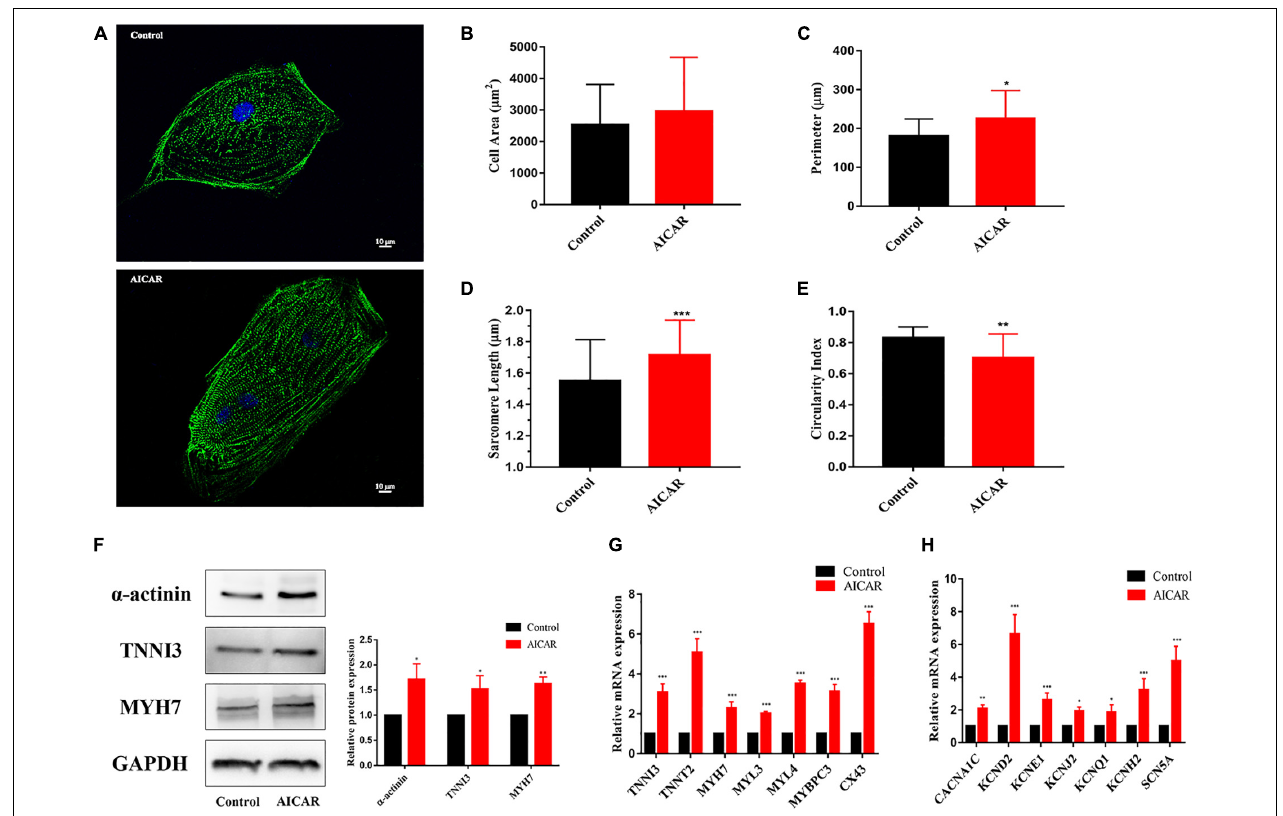
FIGURE 5 | Activation of AMPK improves the morphological and structural maturation of hiPSC-CMs. (A) Representative immunostaining of α -actinin (green) and Hoechst 33342 (blue) in control or AICAR-treated hiPSC-CMs. Scale bar, 10 µ m. Analysis of cell area (B) , perimeter (C) , sarcomere length (D) , and circularity index (E) ( n = 80–100 cells/group). AICAR-treated hiPSC-CMs manifested significant changes in perimeter, sarcomere length and circularity index compared to those in the control cells. (F) Western blot analysis of α -actinin, TNNI3, and MYH7 protein expression in hiPSC-CMs treated with AICAR vs. control ( n = 3). (G) RT-qPCR analysis of the effect of AICAR on the expression of the cardiomyocyte-related sarcomere protein-encoding gene (TNNI3, TNNT2, MYH7, MYL3, MYL4, MYBPC3, and CX43) ( n = 3). (H) RT-qPCR analysis of the effect of AICAR on the expression of electrophysiology-related genes (CACNA1C, KCND2, KCNE1, KCNJ2, KCNQ1, KCNH2, and SCN5A) ( n = 3). * P < 0.05, ** P < 0.01, *** P < 0.001 compared with the control group, unpaired t